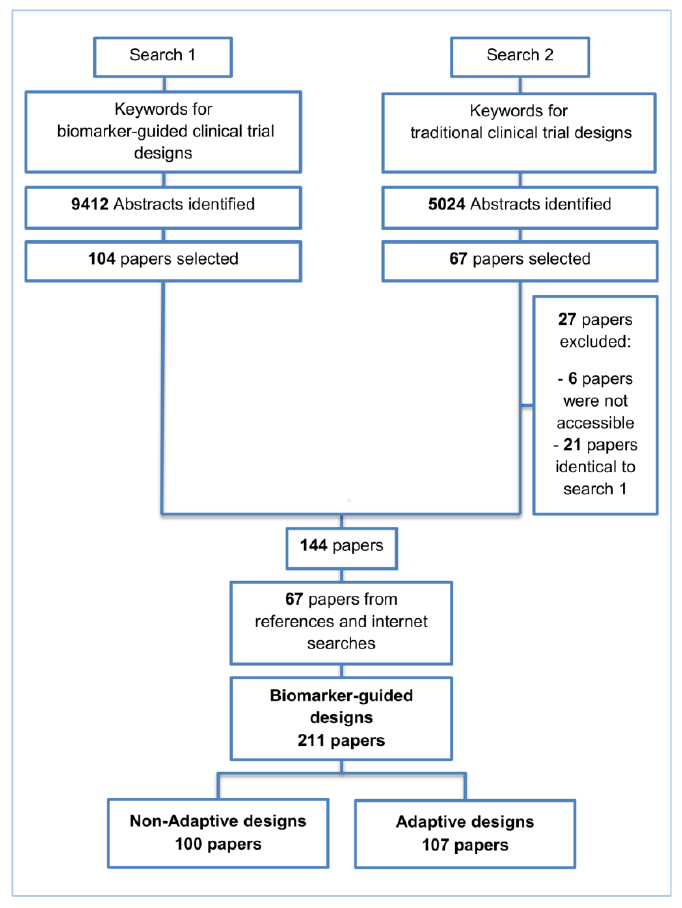
Figure 1. Flow diagram of the review process. From our search strategy a total number of 211